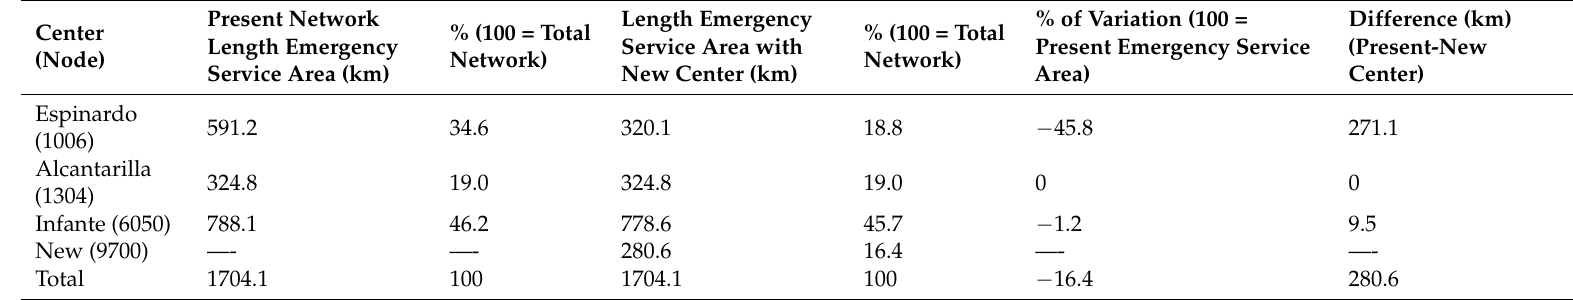
Table 5. Results obtained with the lengths of the sections with the new center included, and difference concerning the present